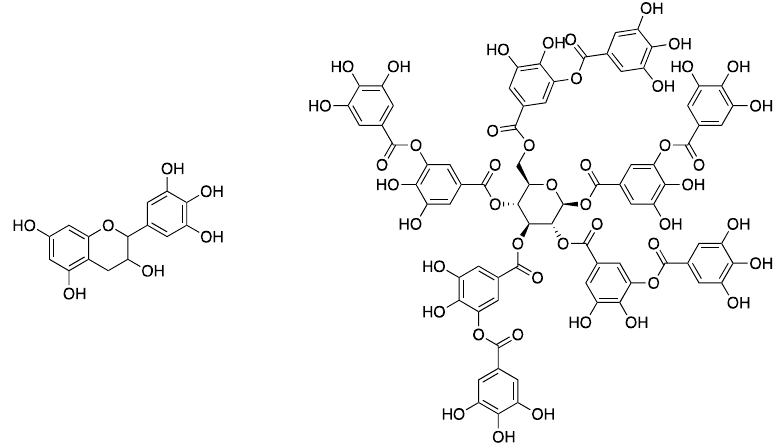
Figure 2. Molecular structures of a condensed tannin monomer ( left ) and a hydrolysable tannin (tannic acid, right ).